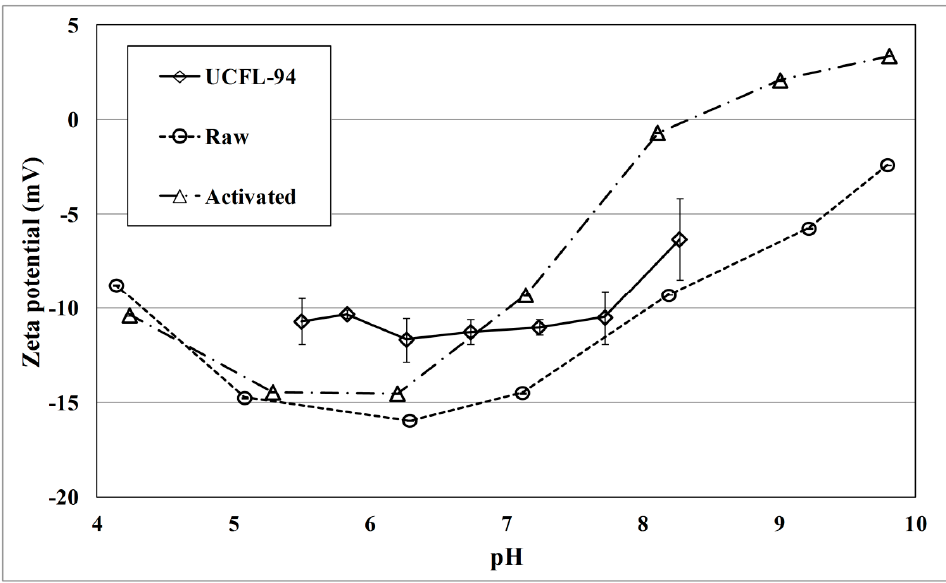
Figure 1. Zeta potential of the hydrochar and Escherichia coli strain over a function of pH. The lines represent the mean zeta potential value and error bars indicate the standard deviation.